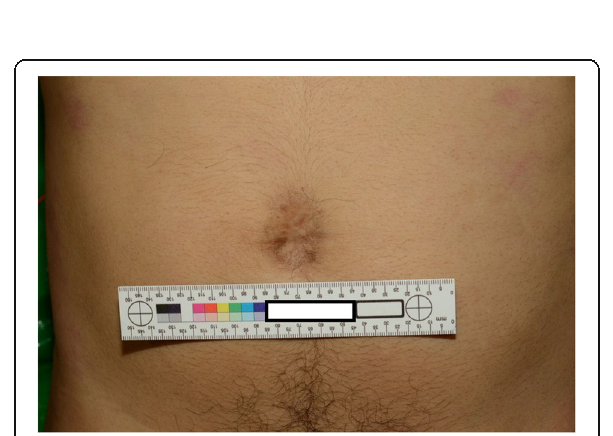
Fig. 2 Close view of the umbilical scar